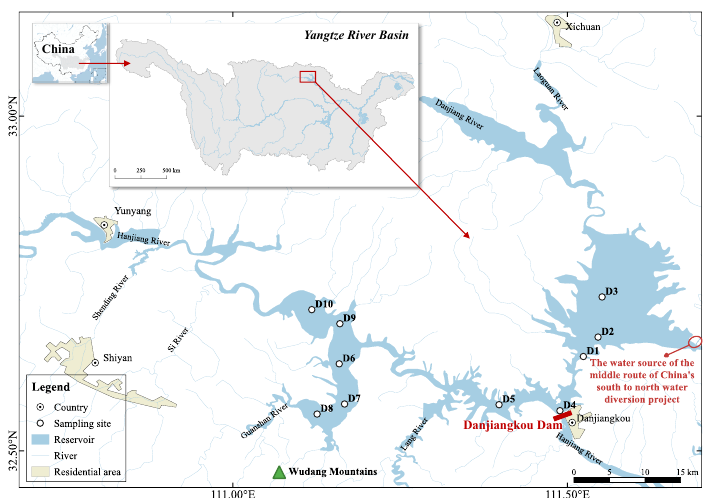
Figure 1. Geographical location and contour map of DJKR, showing the distribution of the sampling sites (D1~D10). The inset map indicates the location of DJKR in the Yangtze River Basin, China.